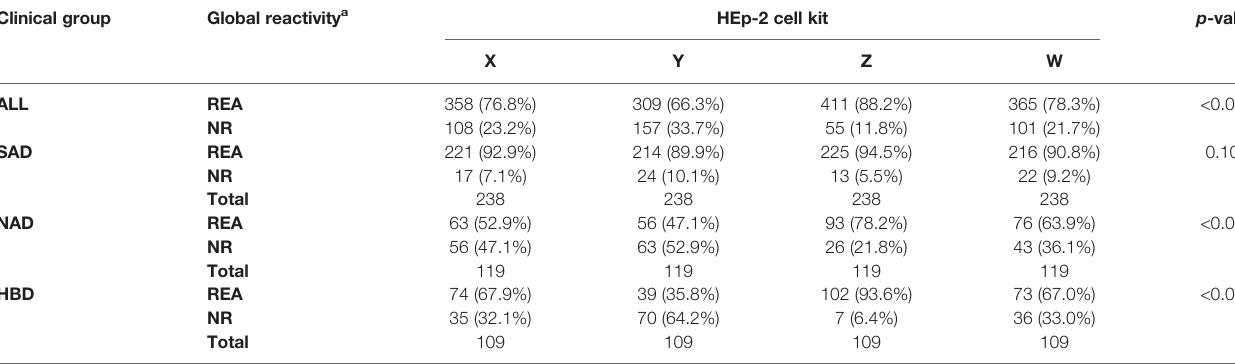
TABLE 1 | Distribution of samples in each clinical group according to the global reactivity in each HEp-2 kit. Clinical group